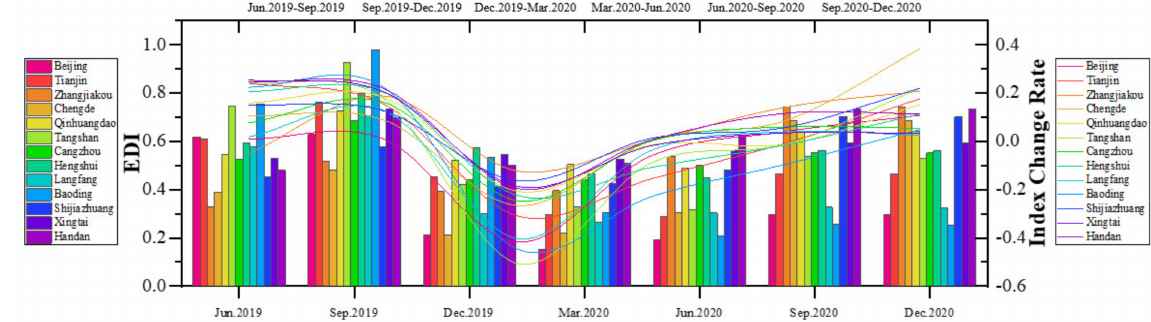
Figure 7. Changes in the EDI of each city in the urban agglomeration before and after the COVID-19.